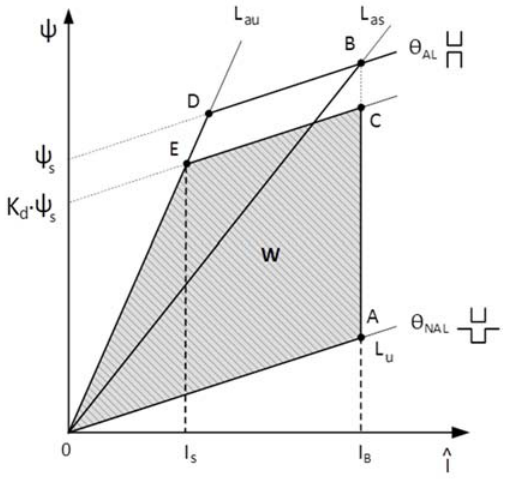
Figure 3. Energy conversion loop.